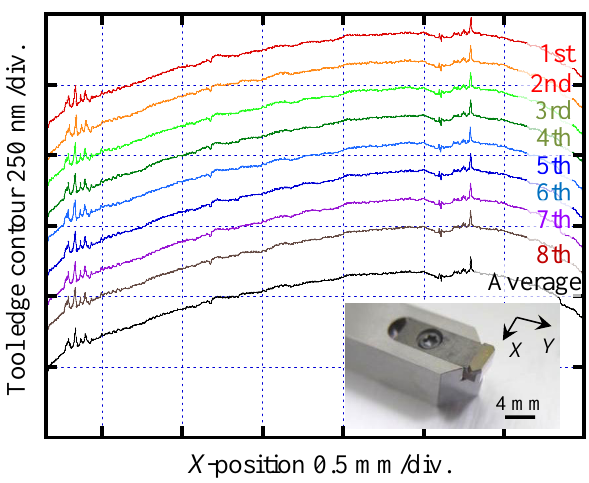
Figure 8. Measured cutting edge contour of the straight-shaped di- amond tool.